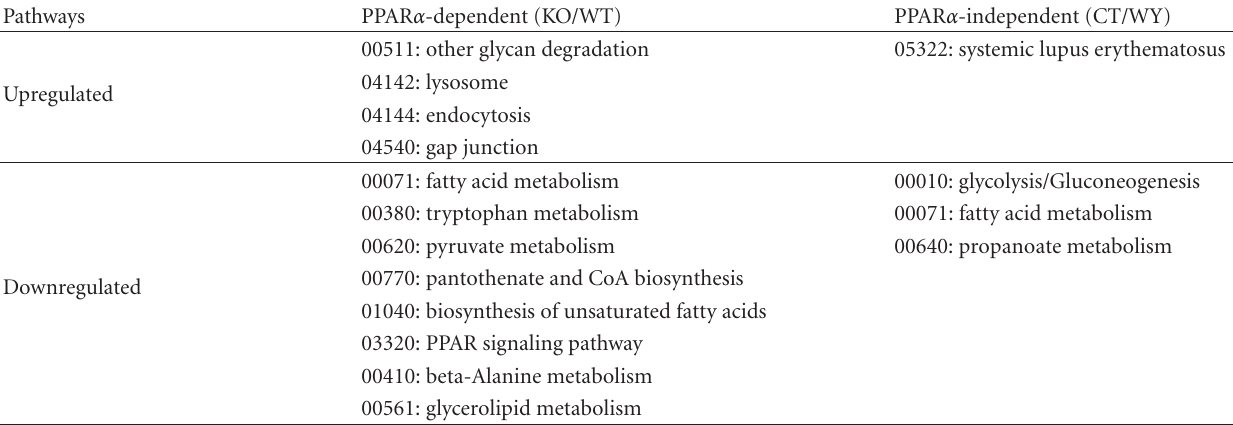
Table 3: The highly common down and up regulated pathways identified in studies of PPAR α -dependent or independent e ff ects both in liver and small intestine tissues of